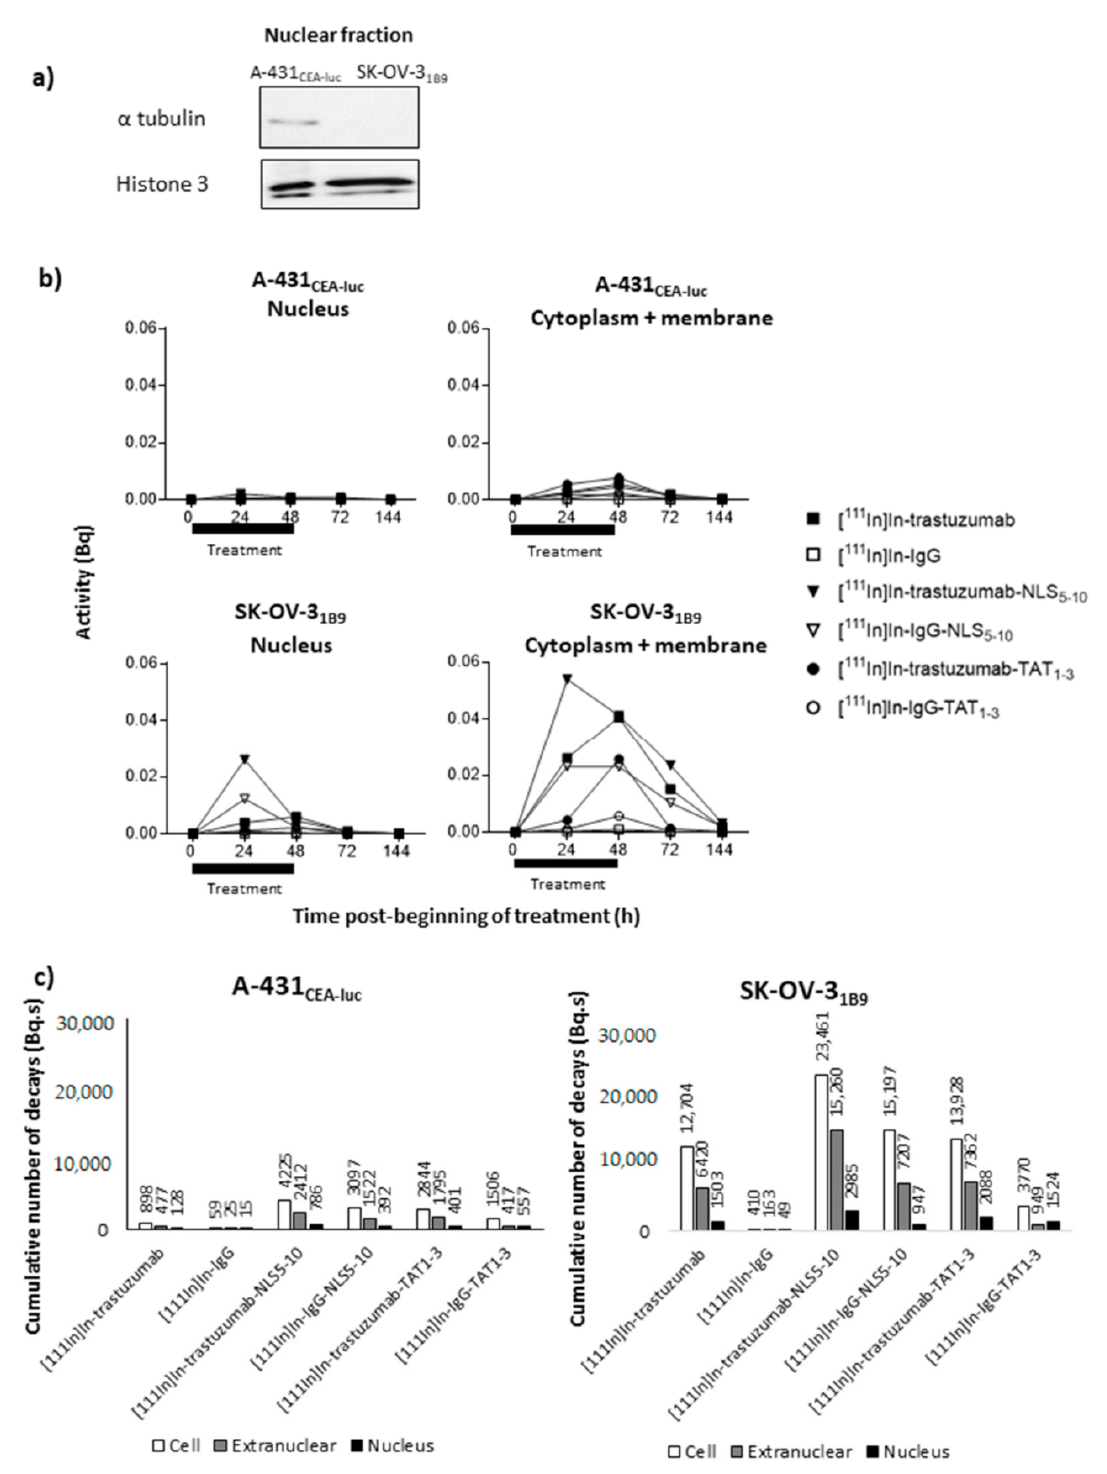
Figure 4. Evaluation of the nuclear and extranuclear uptake of radioactivity ( a ) Expression of histone 3 and α -tubulin was determined in the nuclear fraction by Western blotting to validate the nuclear-fraction isolation technique. ( b ) Cells were exposed to the indicated 111 In-radioimmunoconjugates (0.1 MBq/mL) for 48 h. At different times post-treatment onset (from 24 h to 144 h), cells were counted and fractionated, and activities were measured in whole cells, in the nuclear fraction and in the extranuclear fraction. Using the AUC, ( c ) the cumulative number of decays per cell or nucleus for the different RICs was calculated in the whole cell ( Ã cellular ), in the cytoplasm ( Ã extranuclear ), and in the nucleus ( Ã nuclear